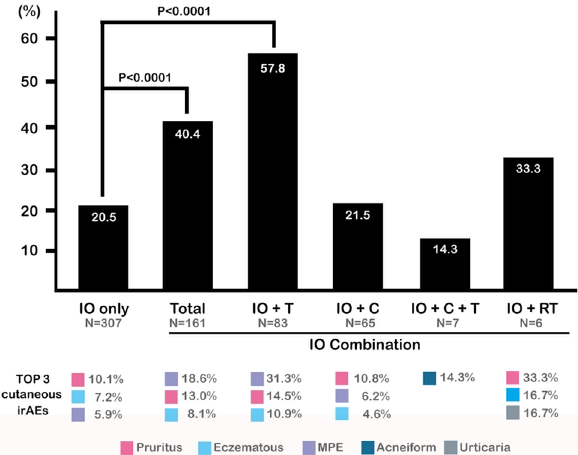
Figure 3. Patients receiving concomitant oncological treatments had a higher incidence of cutaneous irAEs. C chemotherapy; IO immune-oncological treatment; irAEs immune-related adverse events; T molecular target therapy; RT